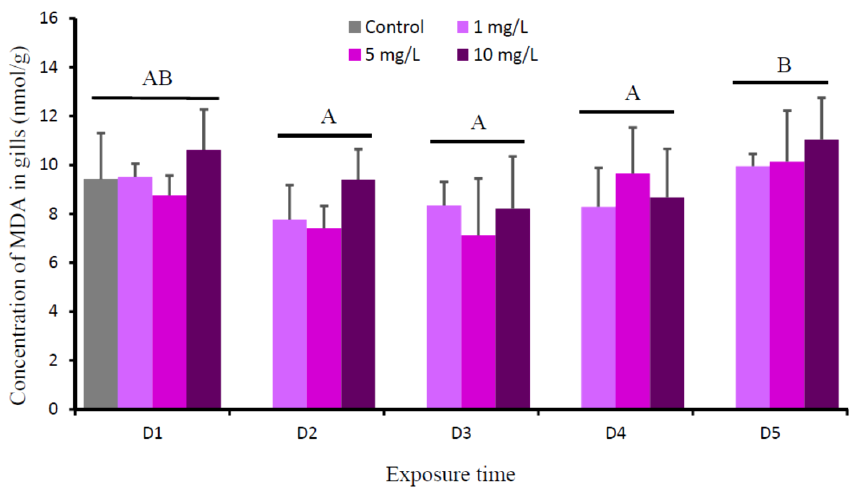
Figure 5. Mean concentration of MDA (nmol/g) in gills of O. niloticus of the control group and after exposed to 1, 5, and 10 mg Cu/L. Different capital letter indicates significance difference between the experimental day (time) for each treatment group on MDA ( P < 0.05) according to Tukey multiple comparison test.